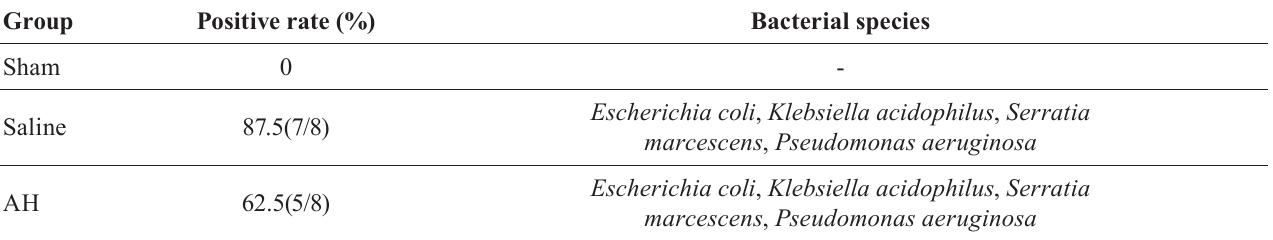
TABLE V - B acterial culture Group